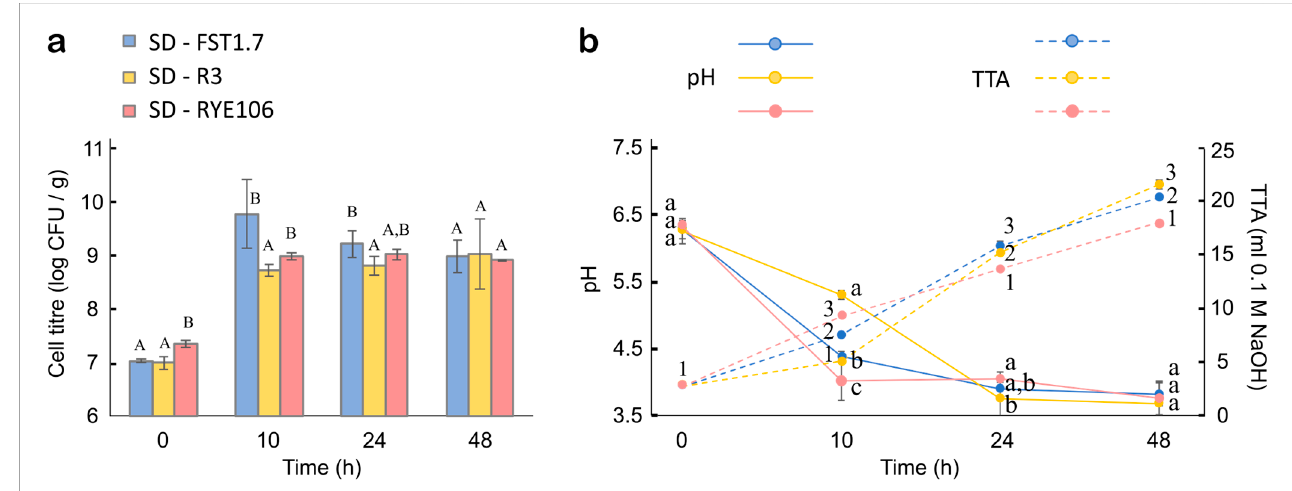
Figure 3. ( a ) Microbial growth (log CFU/g of sourdough); and ( b ) pH (solid line) and total titratable acids TTA (ml of 0.1M NaOH; dashed line) of whole-wheat sourdoughs prepared with Lactiplantibacil- lus plantarum FST1.7 (SD-FST1.7; blue), Lacticaseibacillus paracasei R3 (SD-R3; yellow), and Pediococcus pentosaceus RYE106 (SD-RYE106; red). Error bars = standard deviation. Significant differences ( p < 0.05) in cell titre of isolates at each time interval are indicated by different capital letters, in the pH by lower-case letters, and in the TTA by numbers. Table 3. Organic acids concentration (% dry matter; % DM) and fermentation quotient (FQ) of sourdoughs inoculated with Lactiplantibacillus plantarum FST1.7 (SD-FST1.7), Lacticaseibacillus paracasei R3 (SD-R3), and Pediococcus pentosaceus RYE106 (SD-RYE106).